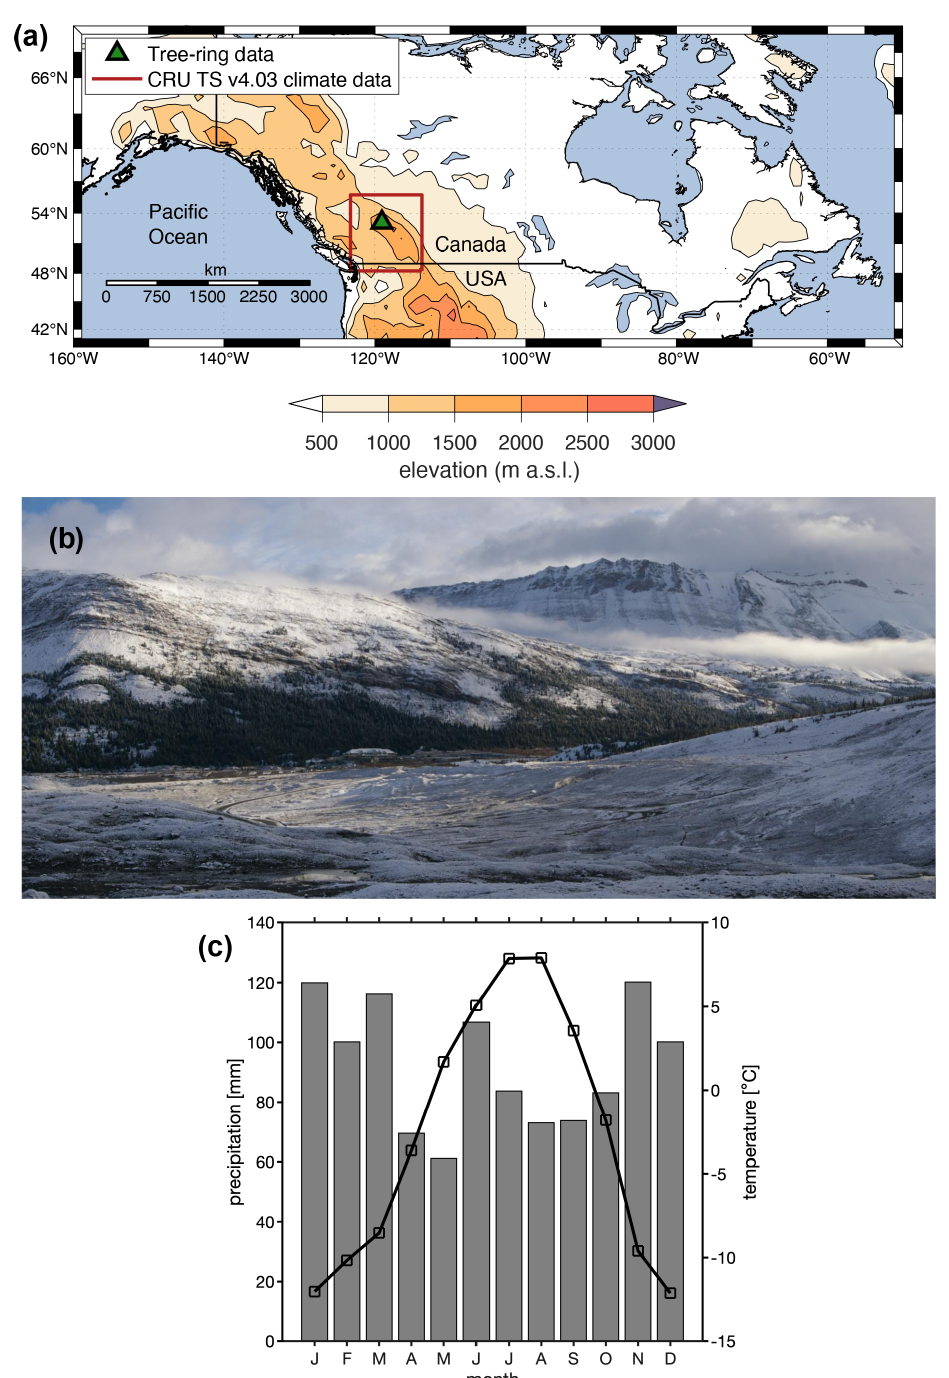
Figure 1. (a) Location of the Columbia Icefield site, Canadian Rockies, where tree cores for dendroanatomical measurements were collected in 2015. (b) The tree-ring sampling site at the Columbia Icefield. The view is to the north from the Athabasca Glacier forefield in September 2018. The 2015 samples were obtained from sites east and west of the Icefield Centre (building located in the middle of the image). The Athabasca Glacier extended to the foot of the slope in the left of the photo in the 1840s. (c) Monthly mean temperature (black line) and total precipitation (gray bars) (1970–2018 averages) for the CRU TS v4.03 grid point (52.25 ◦ N, 117.25 ◦ W) covering the Columbia Icefield area.